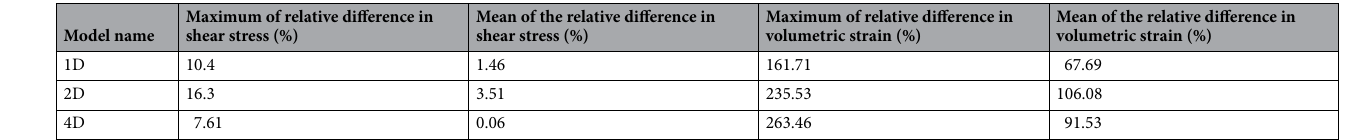
Table 2. Summary of the relative differences in shear stress and volumetric strain.